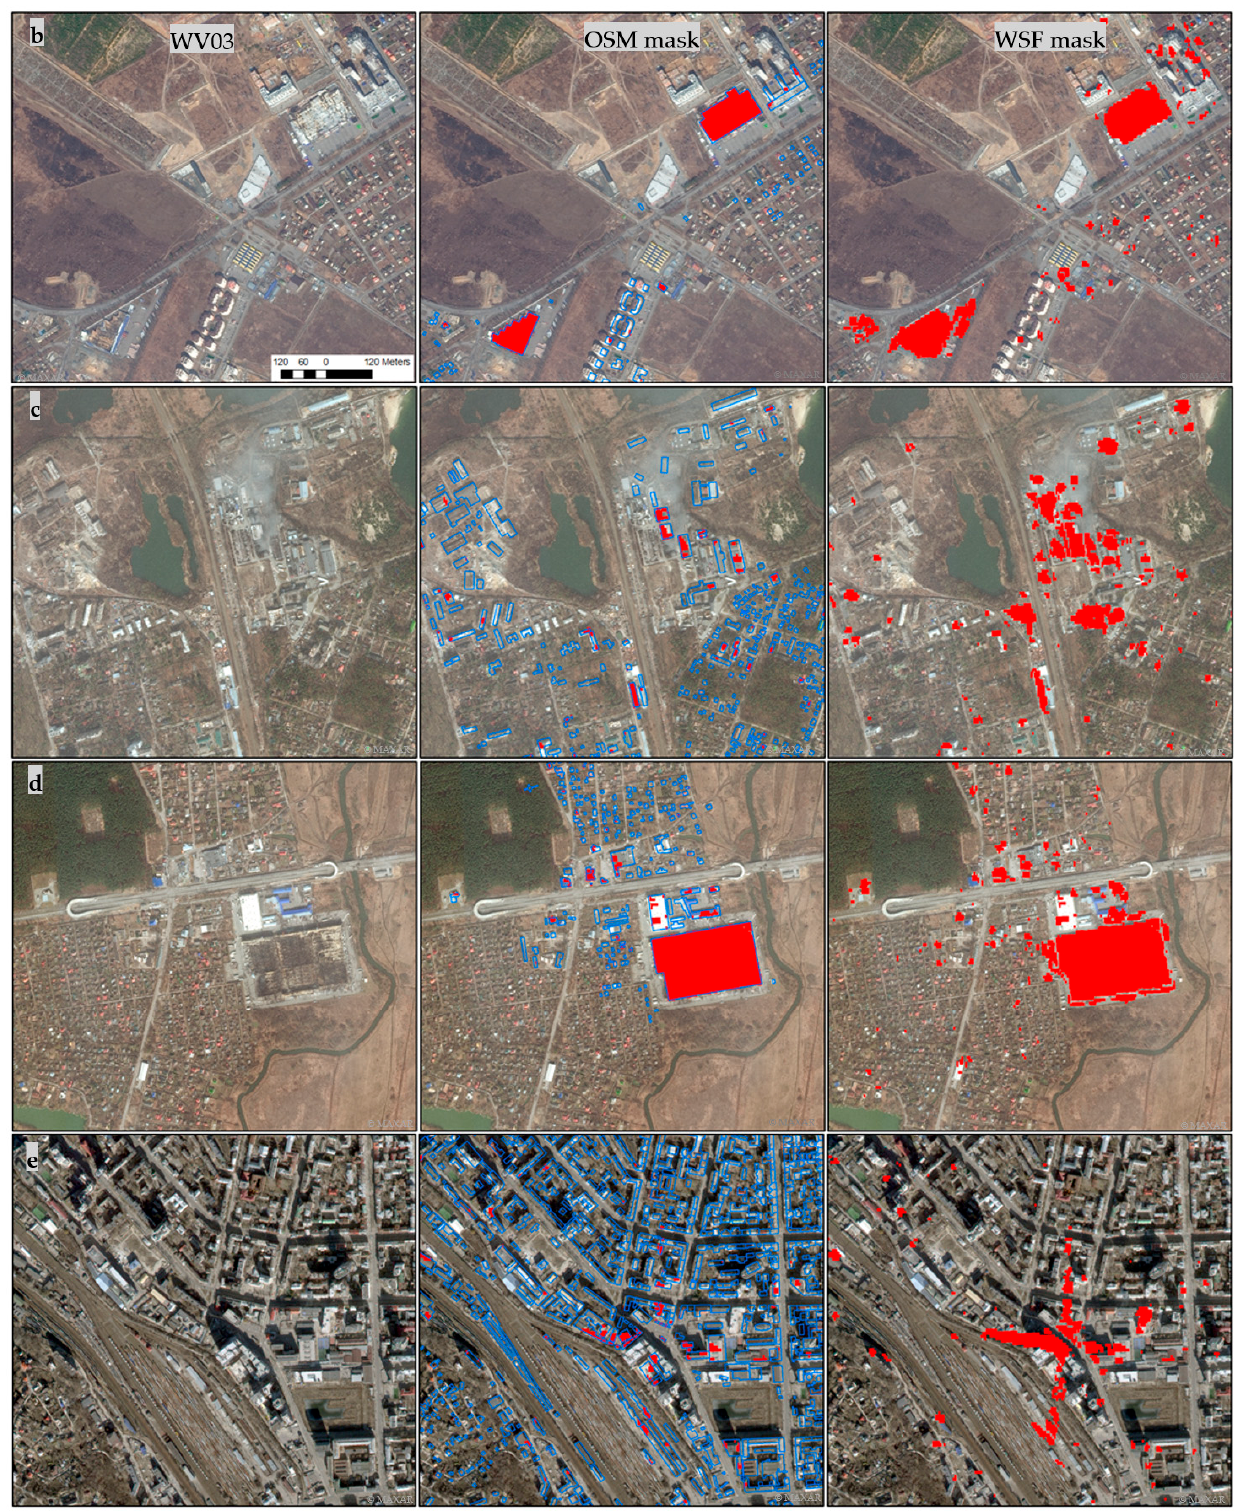
Figure 7. Comparison of Sentinel-1 damaged building results using two different masks (OSM&WSF). ( a ) shows the SAR intensity-based results for the entire area. The locations ( b – e ) were selected as representative areas for comparison with the high-resolution WorldView image. The columns from left to right indicate the WorldView image (31 March 2022), OSM and WSF mask results of the damaged buildings. The scale shown in ( b ) is the same for ( c – e